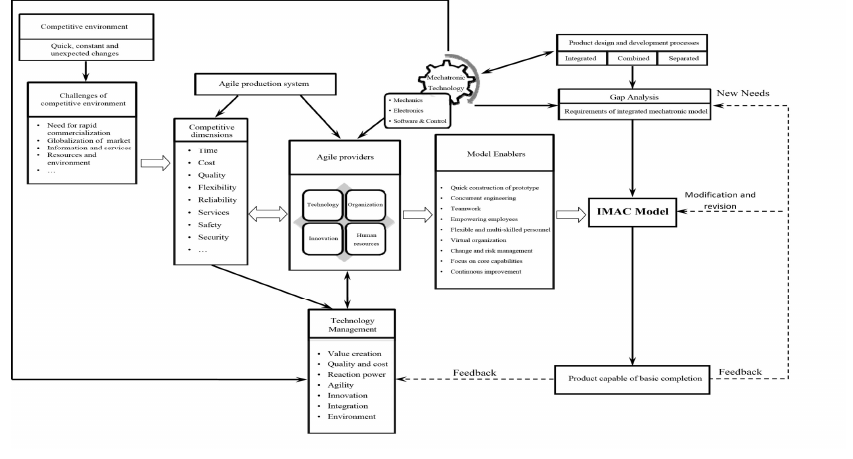
Fig 3 . Conceptual model